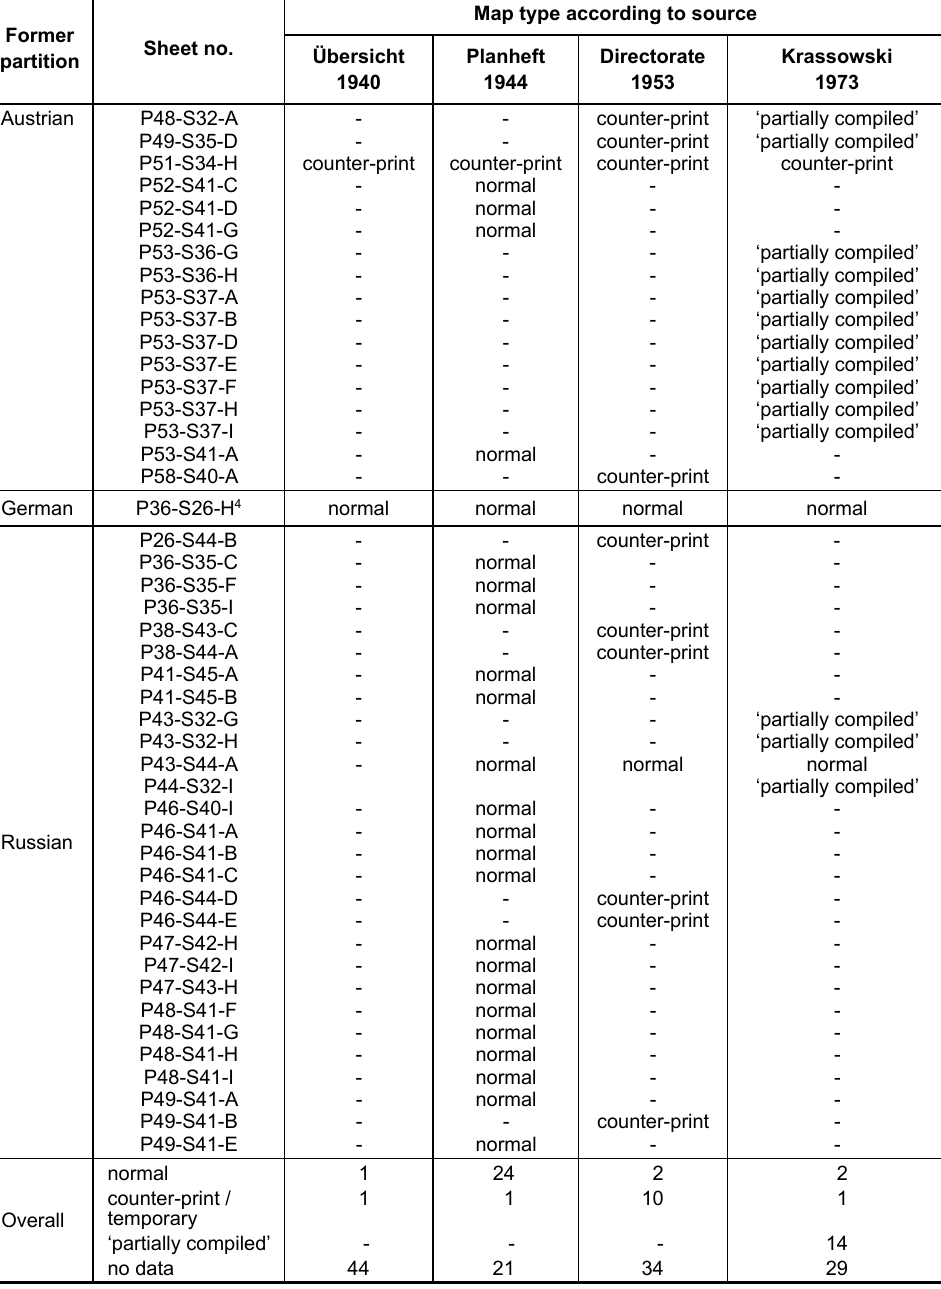
Tab. 3. MGI’s 1:25,000 detailed map sheet types unavailable via Mapster 1